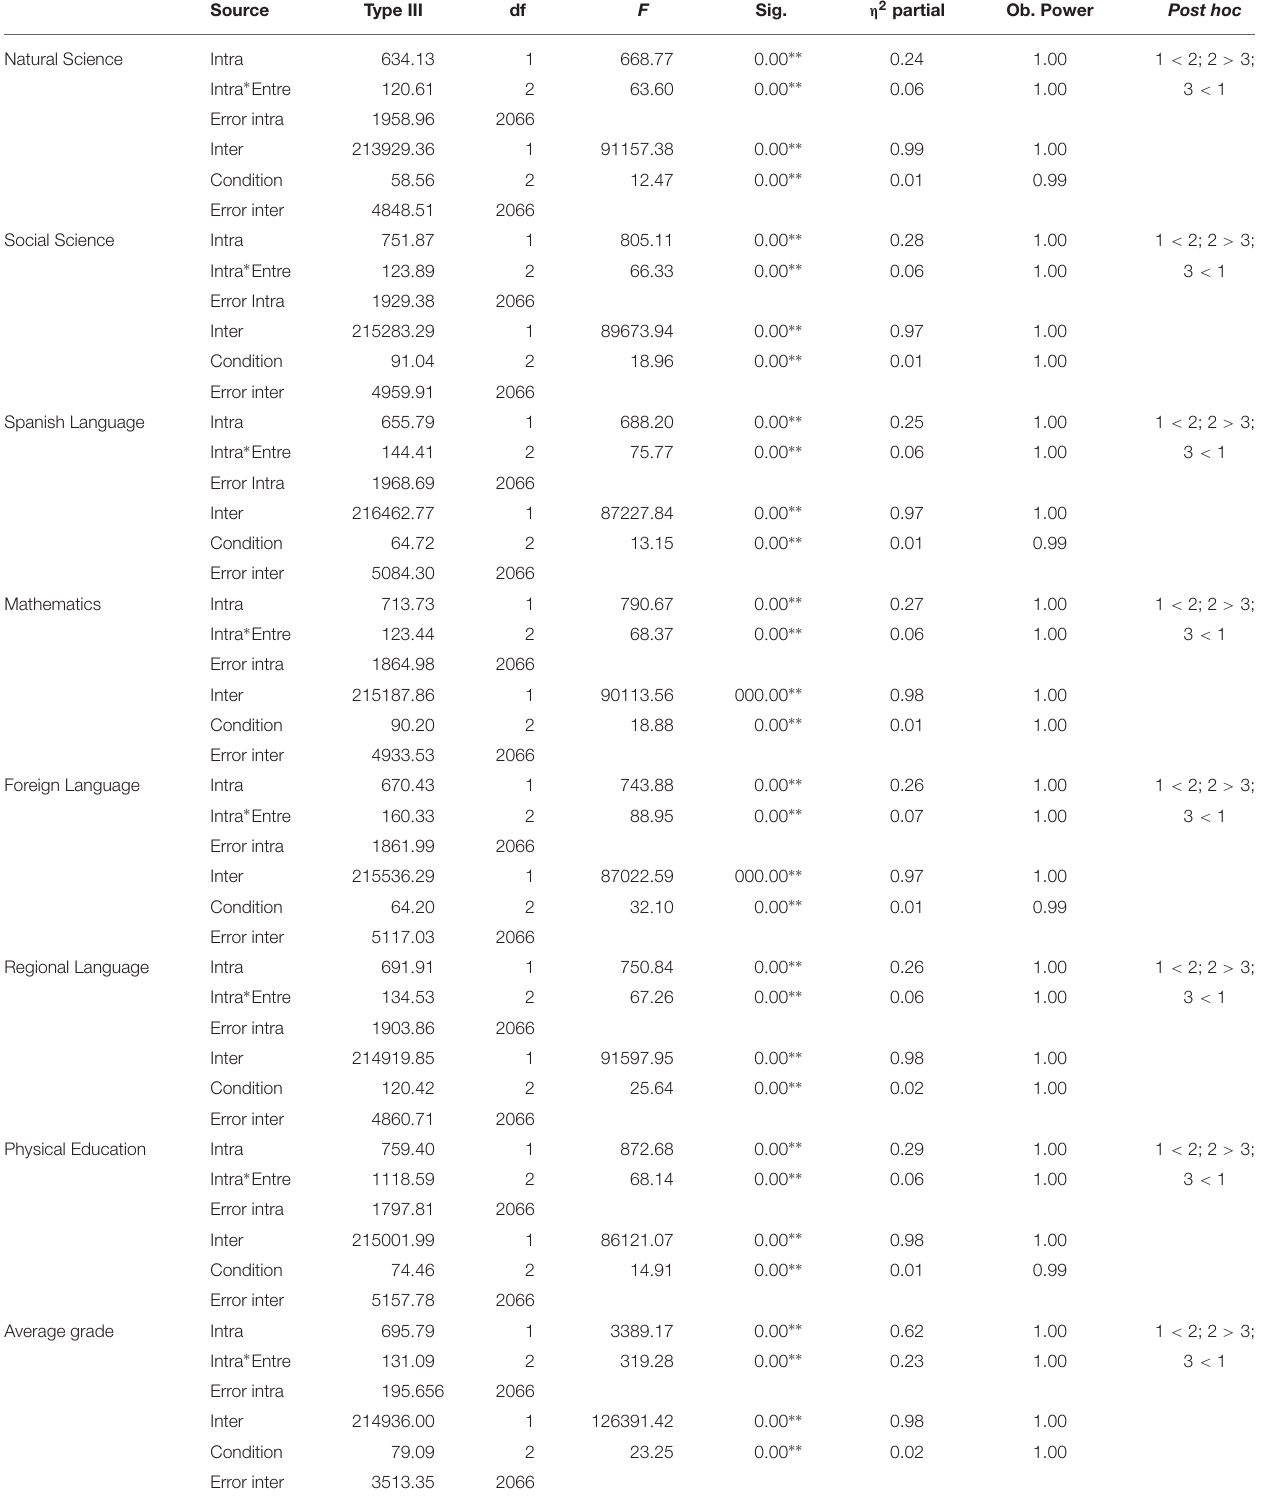
TABLE 2 | Summary of intra-inter subject univariate analysis of